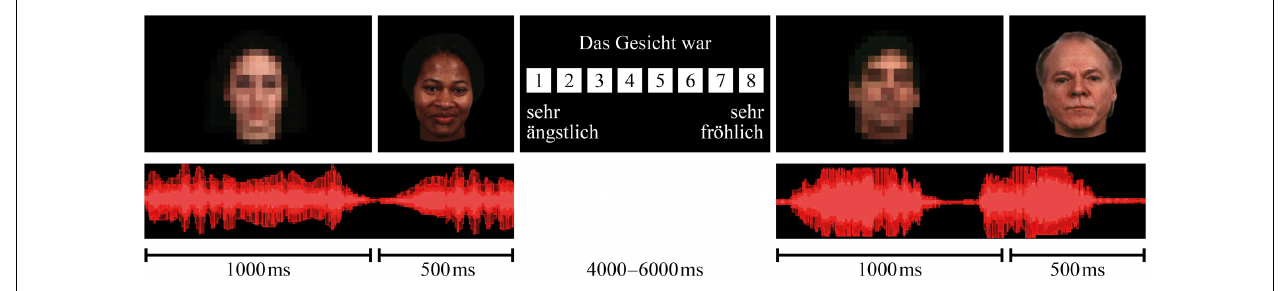
FIGURE 1 | Experimental procedure of the audiovisual paradigm. Every trial started with a sound in combination with a blurred neutral face, after 1000 ms the screen switched to the target face, which was presented with the ongoing sound for another 500 ms.